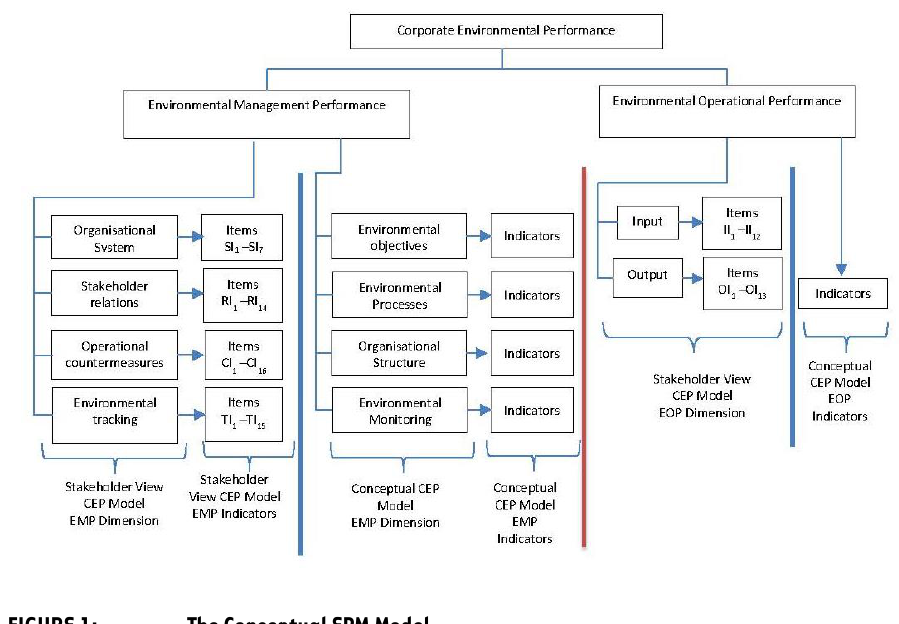
FIGURE 1: The Conceptual EPM Model